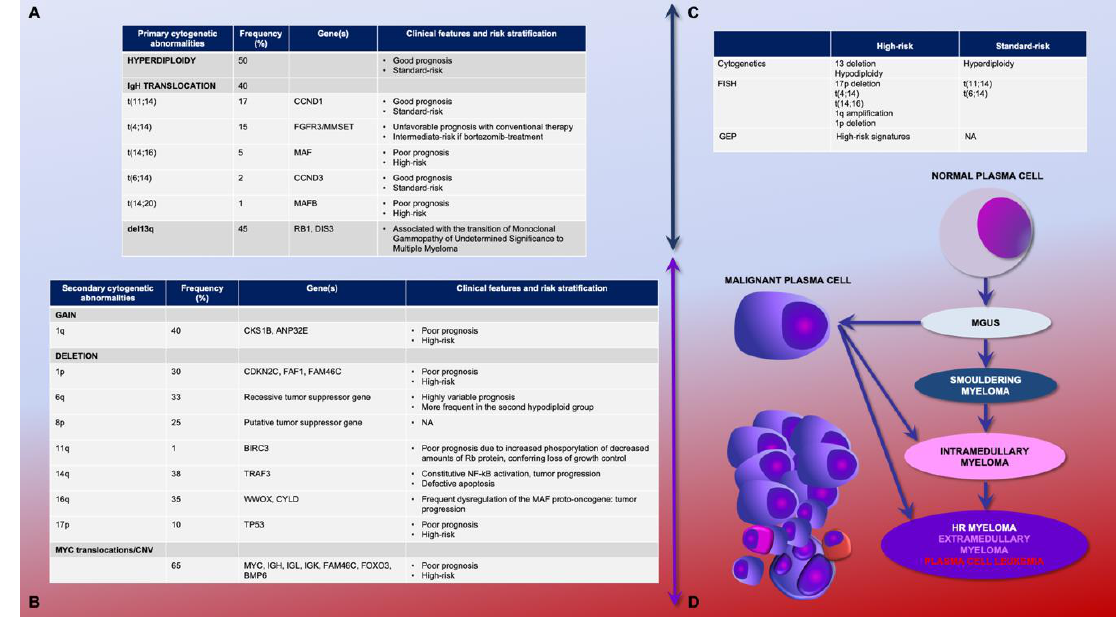
Figure 1. Relationship between peculiar cytogenetic abnormalities and multiple myeloma evolution. ( A ) Primary genetic events occur in the early premalignant phase during the transition from a normal plasma cell to a clonal plasma cell; ( B ) secondary genetic events occurring during the disease progression [6]; ( C ) genetic risk stratification, modified from [5]; ( D ) multiple myeloma disease evolution. GEP: gene expression profile. MGUS: monoclonal gammopathy of undetermined significance.